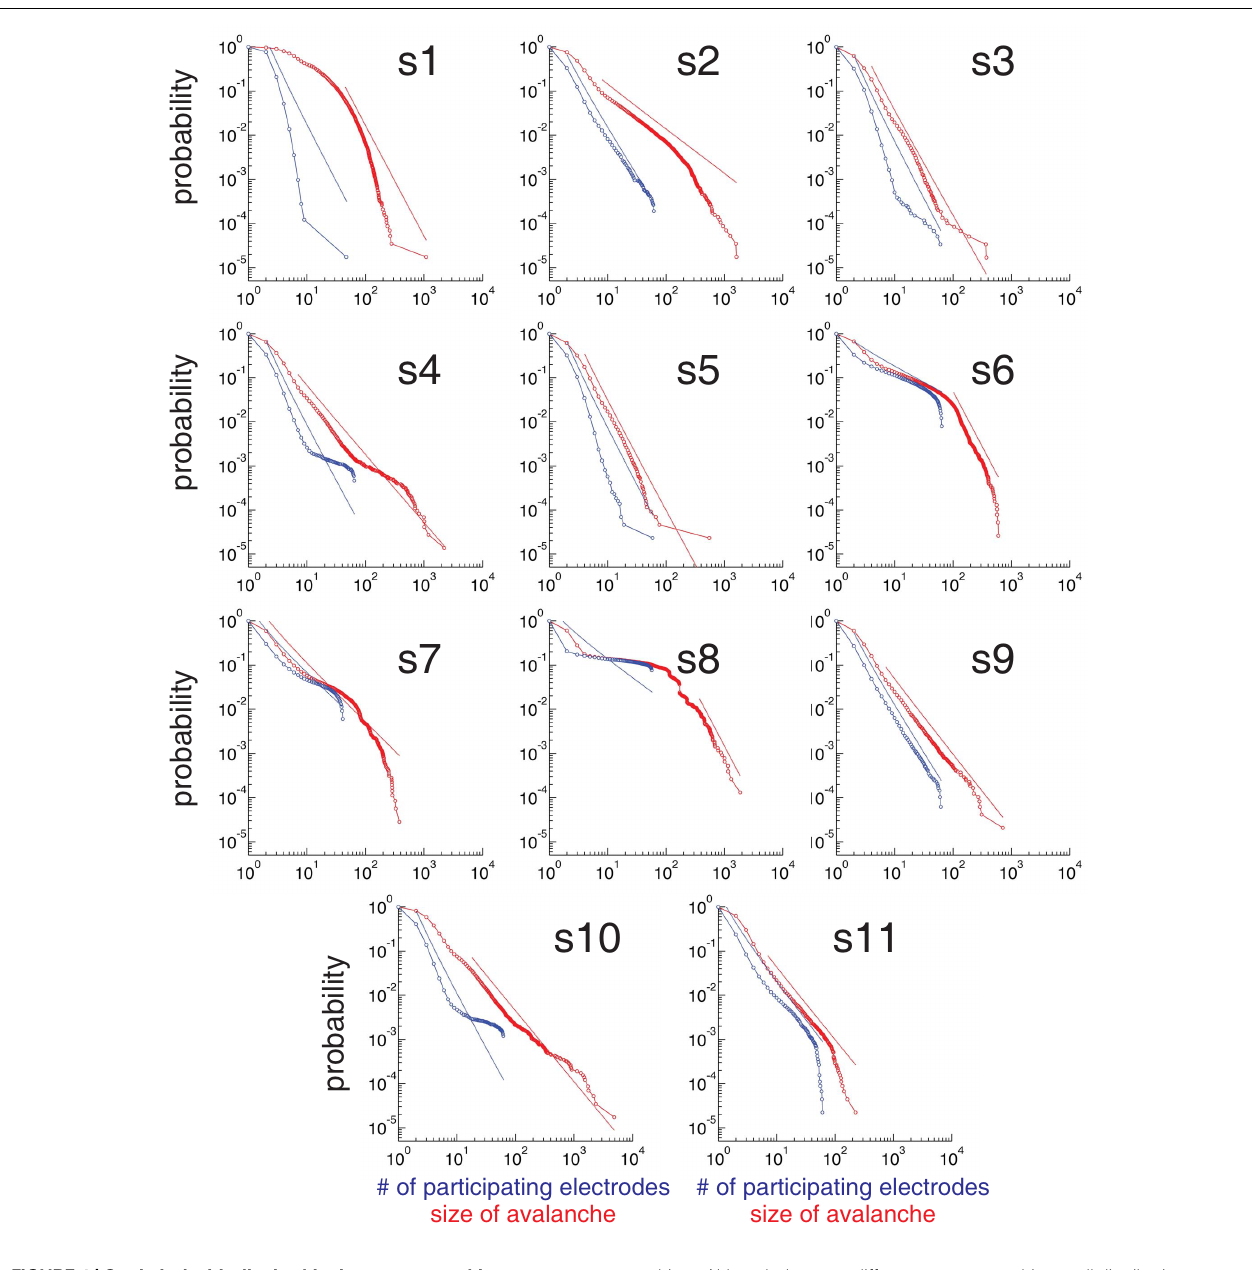
FIGURE 4 | Statistical criticality is ubiquitous among subjects. Cumulative distribution plots of the number of electrodes that participate in an avalanche (blue) and the size of the avalanche (red) for every subject